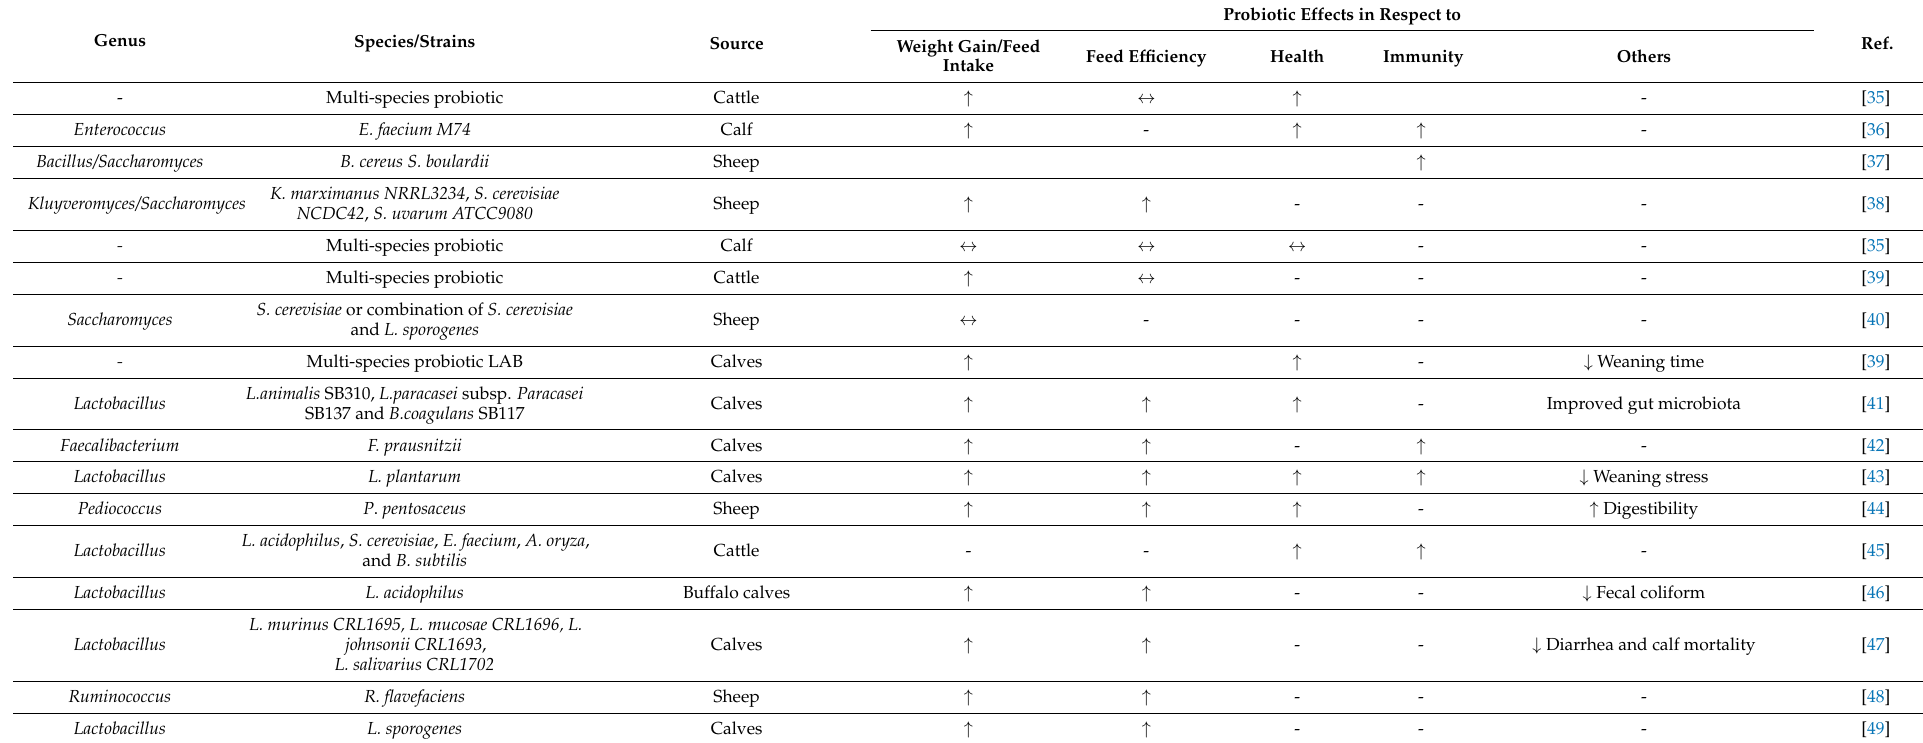
Table 2. Summary of current ruminant trials (in vivo) measuring the effects of probiotics on health and